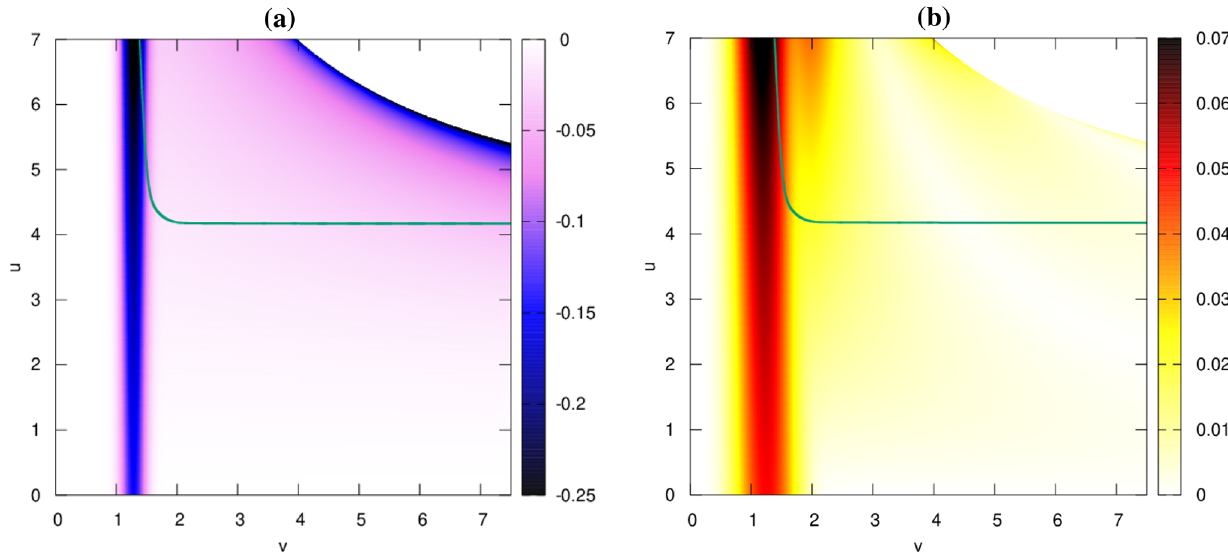
Fig. 8 The (v u ) -distribution of a the neutral scalar field, h , and b the moduli of the complex scalar field, | X | , for the same parameters as in Fig.